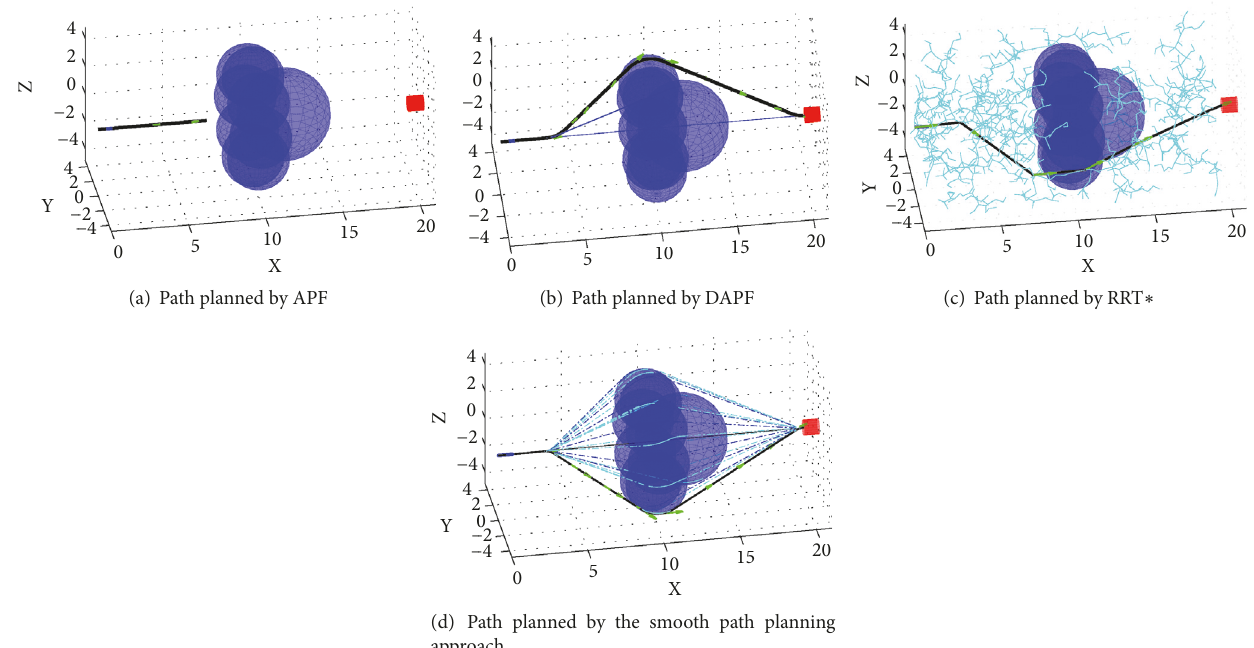
Figure 7: Simulation results of the path planning approaches in scenario